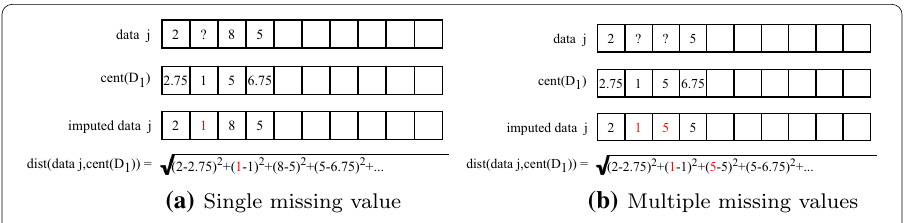
Fig. 9 Example of imputing a mixed dataset for ( a ) a single missing value, and ( b ) multiple missing values